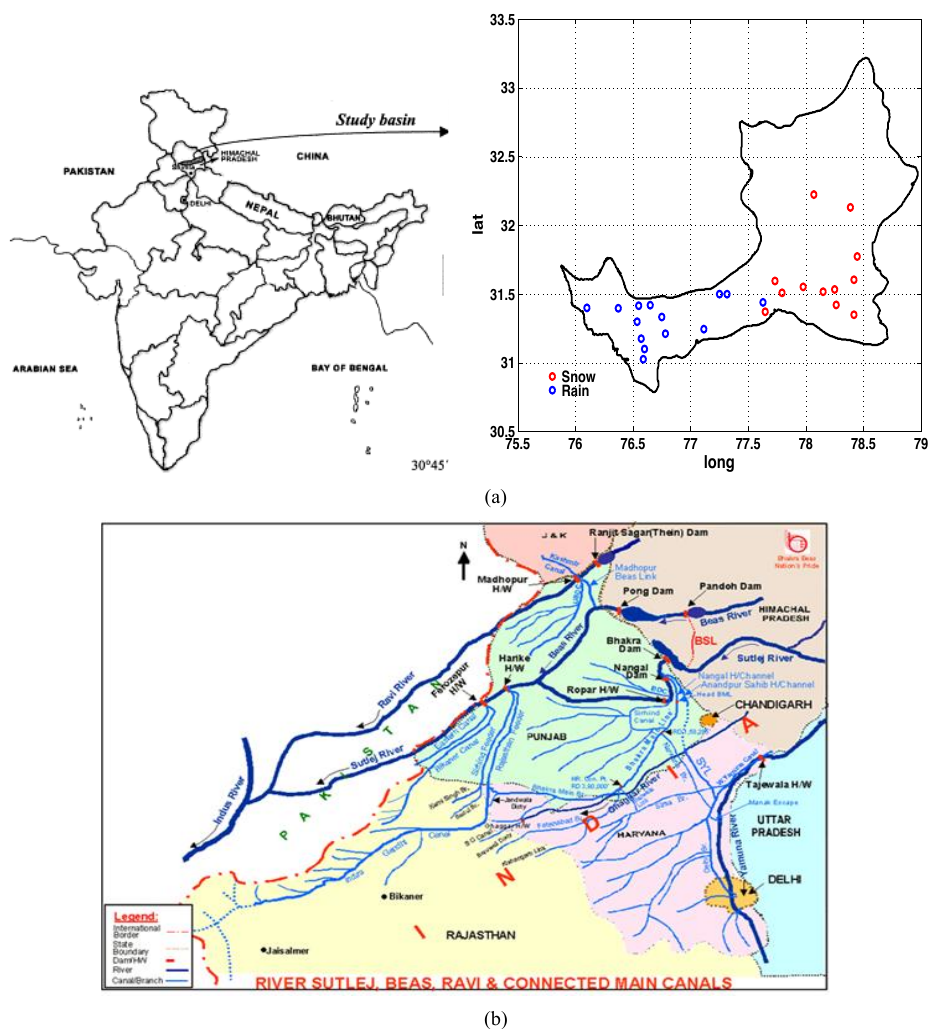
Fig. 1. (a) Indian part of Satluj River basin up to Bhakra Reservoir with location of hydrometeorological stations; (b) entire Satluj River network including location of Beas Satluj Link (BSL)